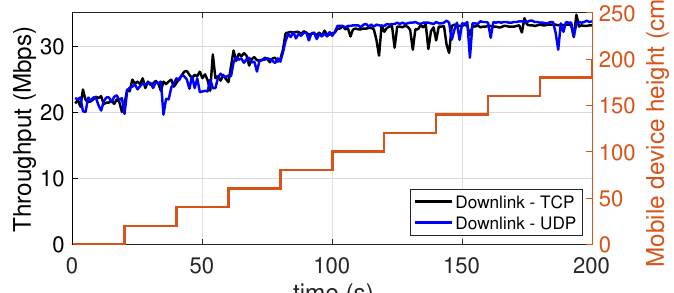
Figure 16. Downlink throughput with the mobile device placed at different heights. TCP and UDP.